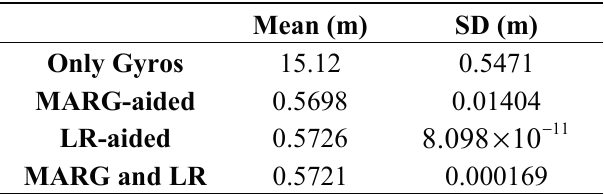
Table 4. Statistical analysis of positioning